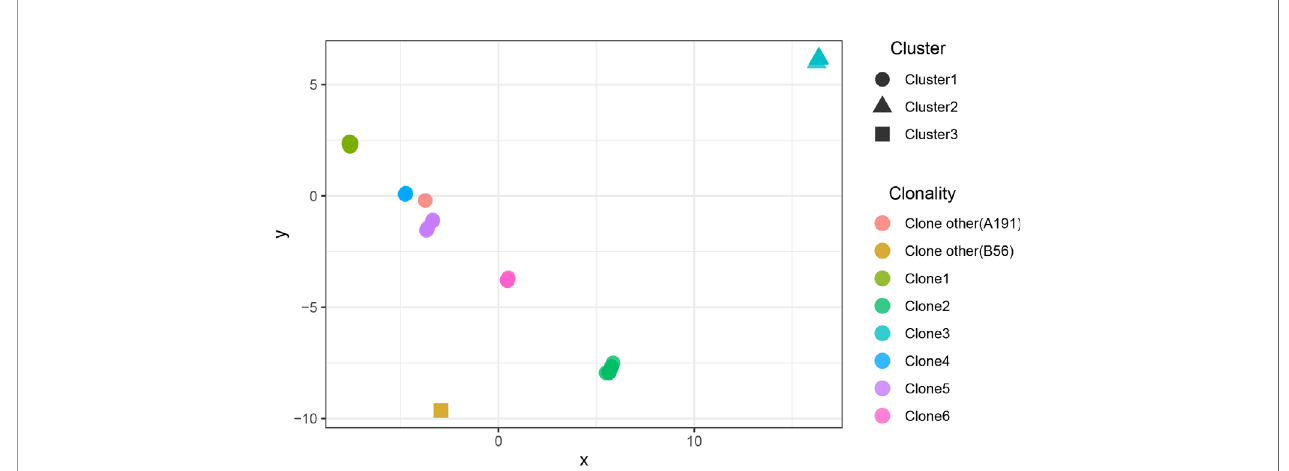
FIGURE 4 | The scatter plots of SNP distance reduced dimension among CRAB isolates. The SNP distance matrix is standardized by R function scale and then the function dist (method = “ euclidean ” ) is used to calculate the distance between variables. The results are visualized by using the function cmdscale and by Package ggplot2.